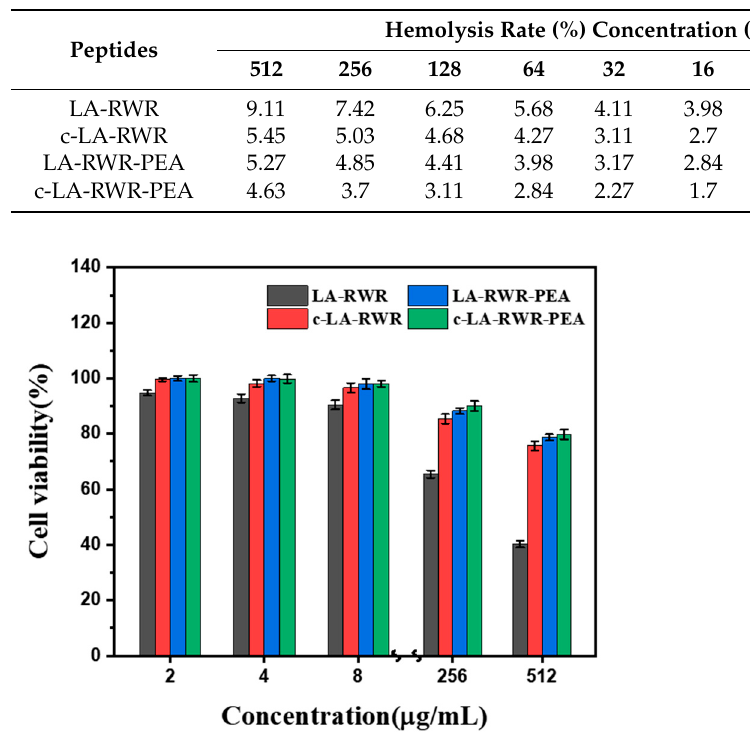
Table 3. Hemolysis rates of LA-RWR, c-LA-RWR nanoparticles, LA-RWR-PEA, and c-LA-RWR- PEA nanoparticles.